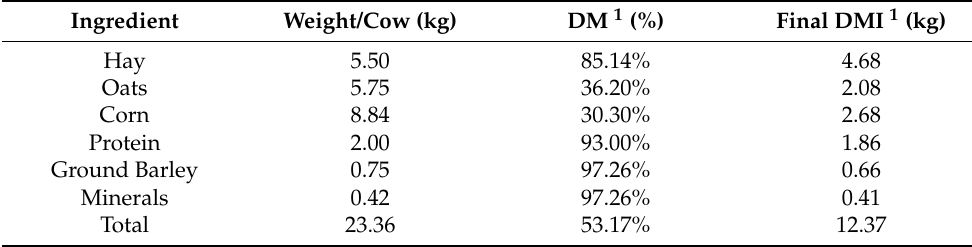
Table 1. Ingredients of the prepartum diet for the dry-off